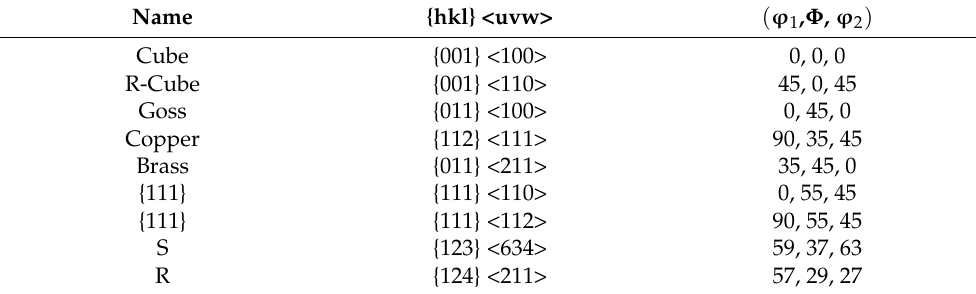
Table 4. Typical texture.